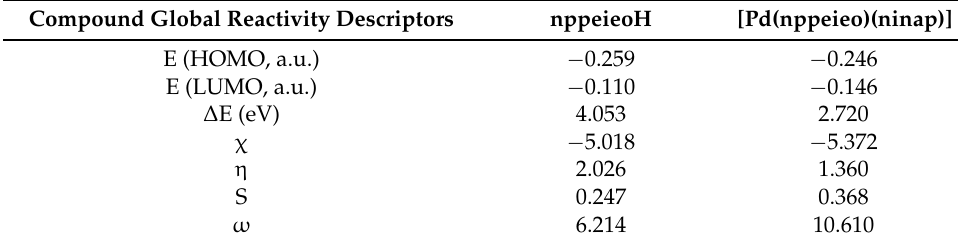
Table 2. HOMO and LUMO energies, energy gap ( ∆ E), absolute electronegativity ( χ ) chemical hardness ( η ), softness (S) and electrophilicity index ( ω ) of nppeieoH and [Pd(nppeieo)(ninap)]. Compound Global Reactivity